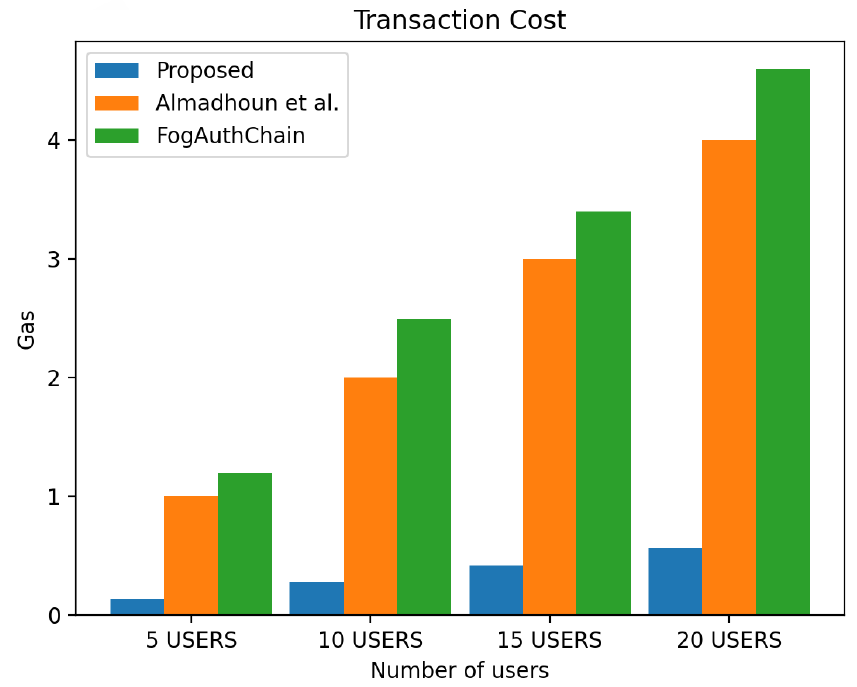
Figure 10. Comparison of experimental results of the proposed system and existing systems (Almad- houn et al. [36] and FogAuthChain [1]) on authentication transaction cost.